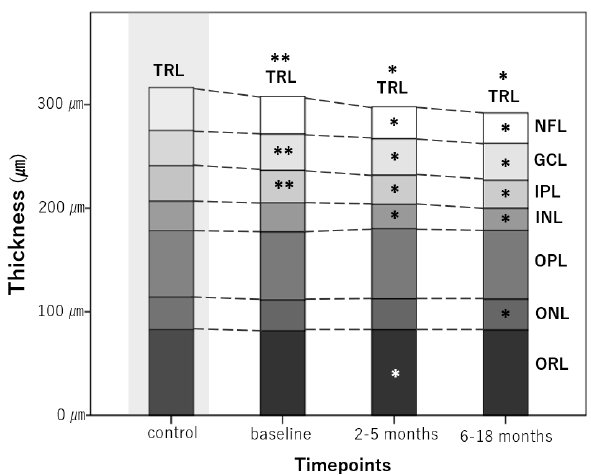
Figure 2. Longitudinal changes in average retinal layer thicknesses at different time points. A star (*) indicates a significant change in thickness compared with the previous time point. A double star (**) indicates a significant difference between control eyes and the first measurement taken in optic neuritis eyes. TRL, total macular volume; NFL, nerve fiber layer; GCL, ganglion cell layer; IPL, inner plexiform layer; INL, inner nuclear layer; OPL, outer plexiform layer; ONL, outer nuclear layer; ORL, outer retinal layer.